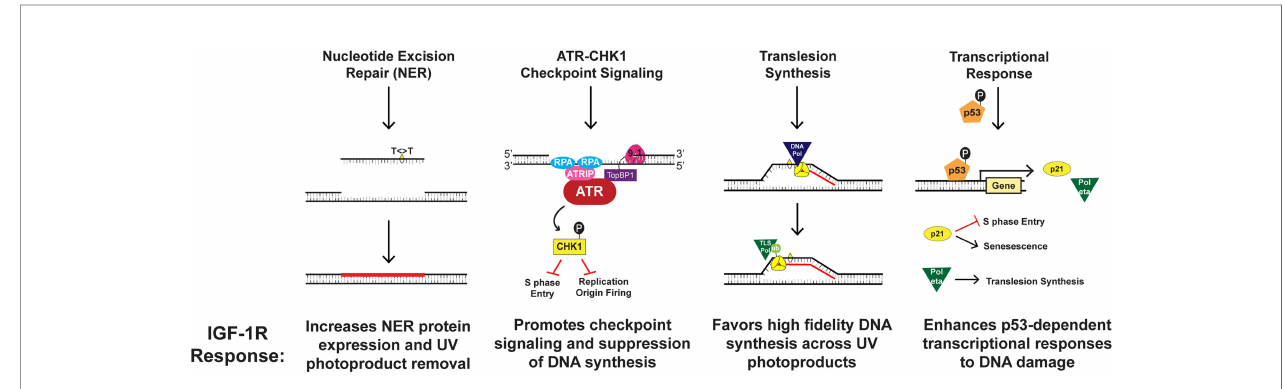
FIGURE 1 | Mechanisms by which IGF-1R activation results in keratinocyte protection from